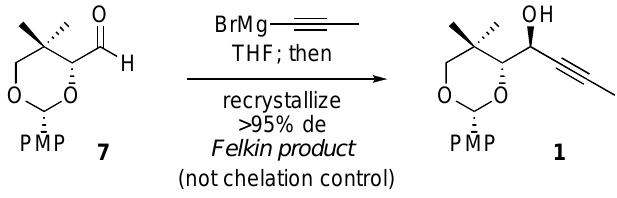
Scheme 2. The major diastereomer (1) is highly crystalline.